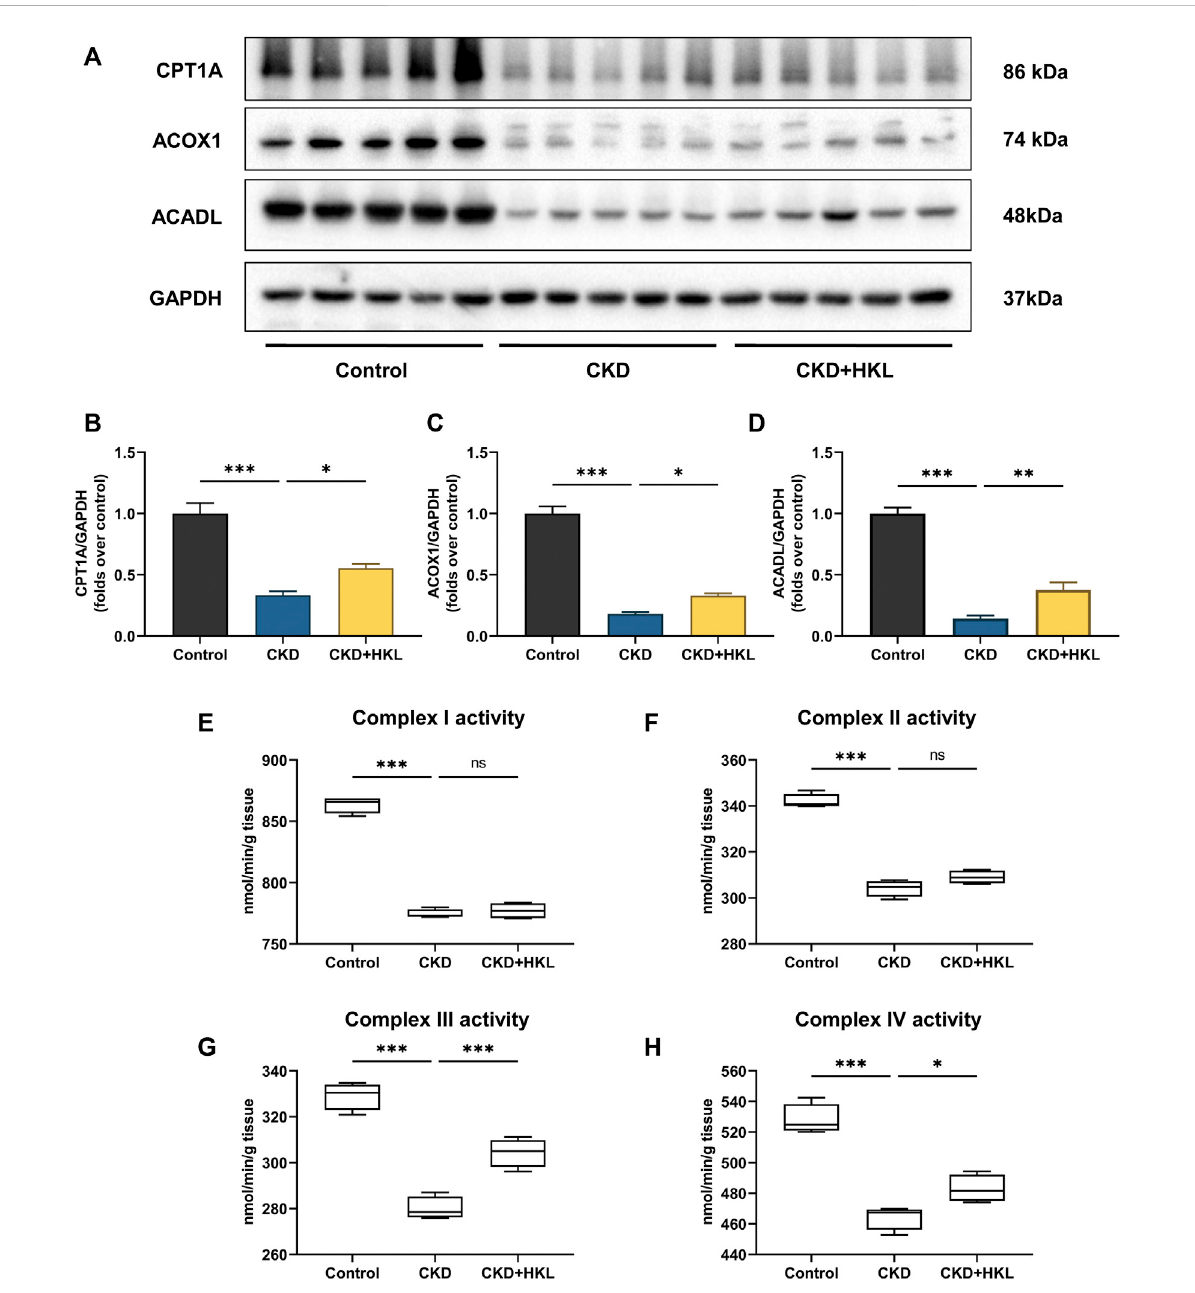
FIGURE 9 EffectsofHKLonfattyacid oxidationinthekidneyofCKDrats. (A) RepresentativeWesternblotbandsofCPT1A, ACOX1,andACADL expression inthekidneysofrats. (B – D) DensitometricanalysisofCPT1A,ACOX1,andACADLnormalizedtoGAPDHcontent.Dataareexpressedasmean±SEM, n = 5. (E – H) The activity of mitochondrial respiratory complex I, II, III, and IV in the kidney of rats. Data are expressed as min to max, n = 4. * p <